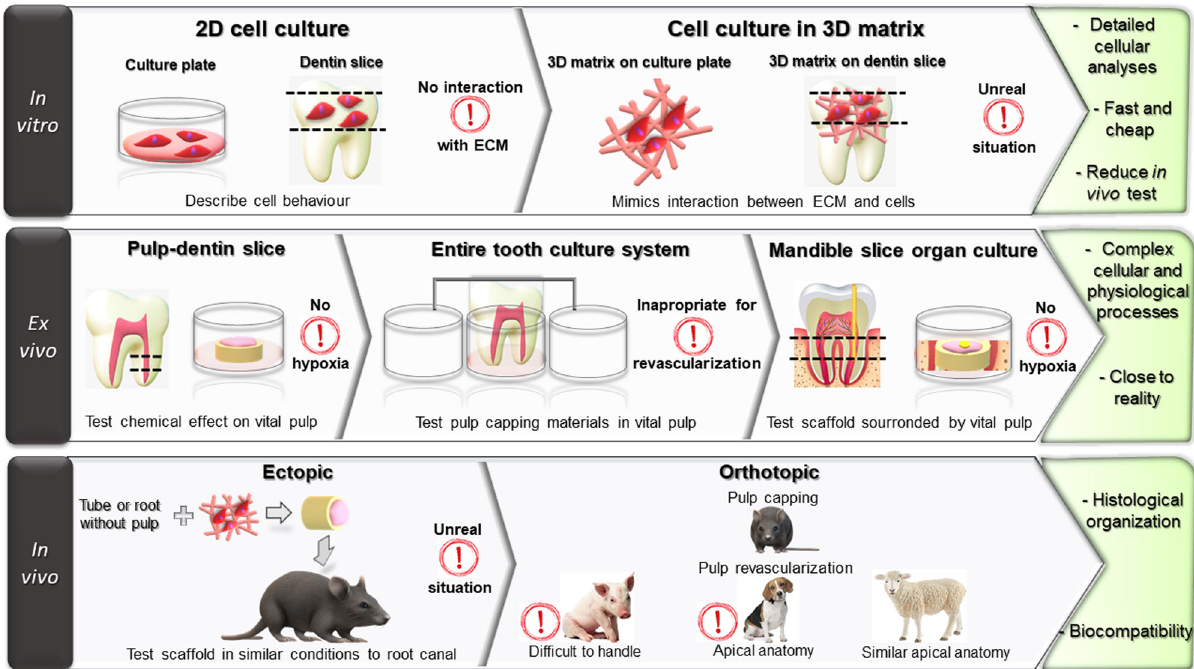
Fig. 1 In vitro, ex vivo, and in vivo models developped for dental pulp